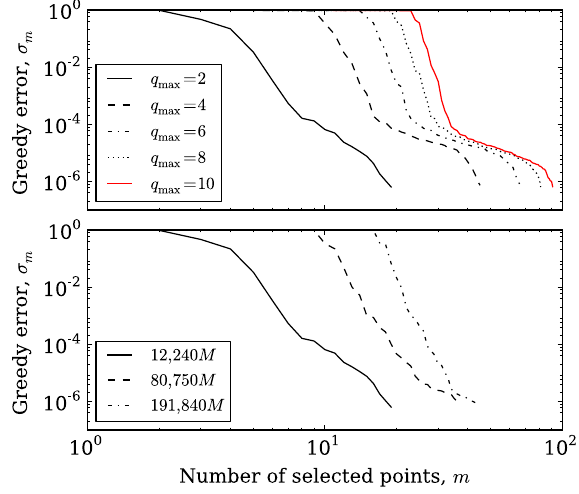
FIG. 12. Top panel: The greedy error in Eq. (9) computed for waveforms of fixed duration and mass ratios in ½ 1 ; q q 2 , 4, 6, 8, and 10. The curves correspond to cases 1, 3, 4, max ¼ 5, and 6 from Table I. Bottom panel: Greedy error for mass ratios in [1,2] with different durations in time and thus numbers of cycles. The curves correspond to cases 1, 7, and 8 from Table